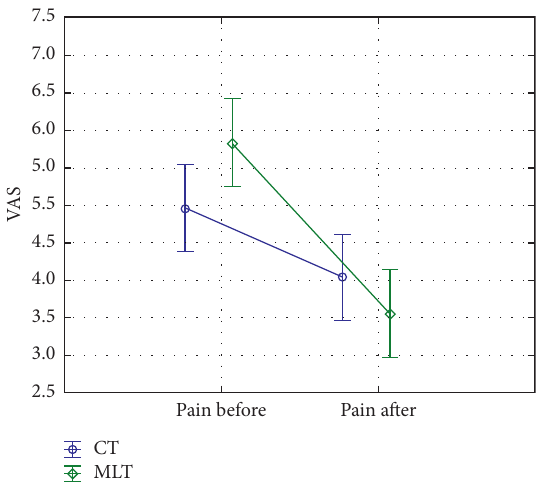
Figure 3: Changes in mean values in the VAS scale before and after the therapy (95% confidence interval for the mean value). ∗ MLT, LED light therapy with electromagnetic field; CT, cryotherapy. Table 2: Results of the regression model